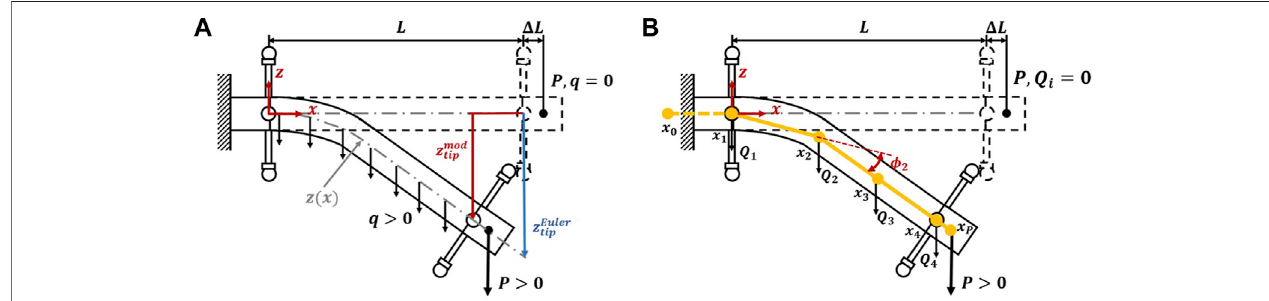
FIGURE 3 | (A) Euler-Bernoulli beam model in the context of the experiment. (B) PDER model in the context of the